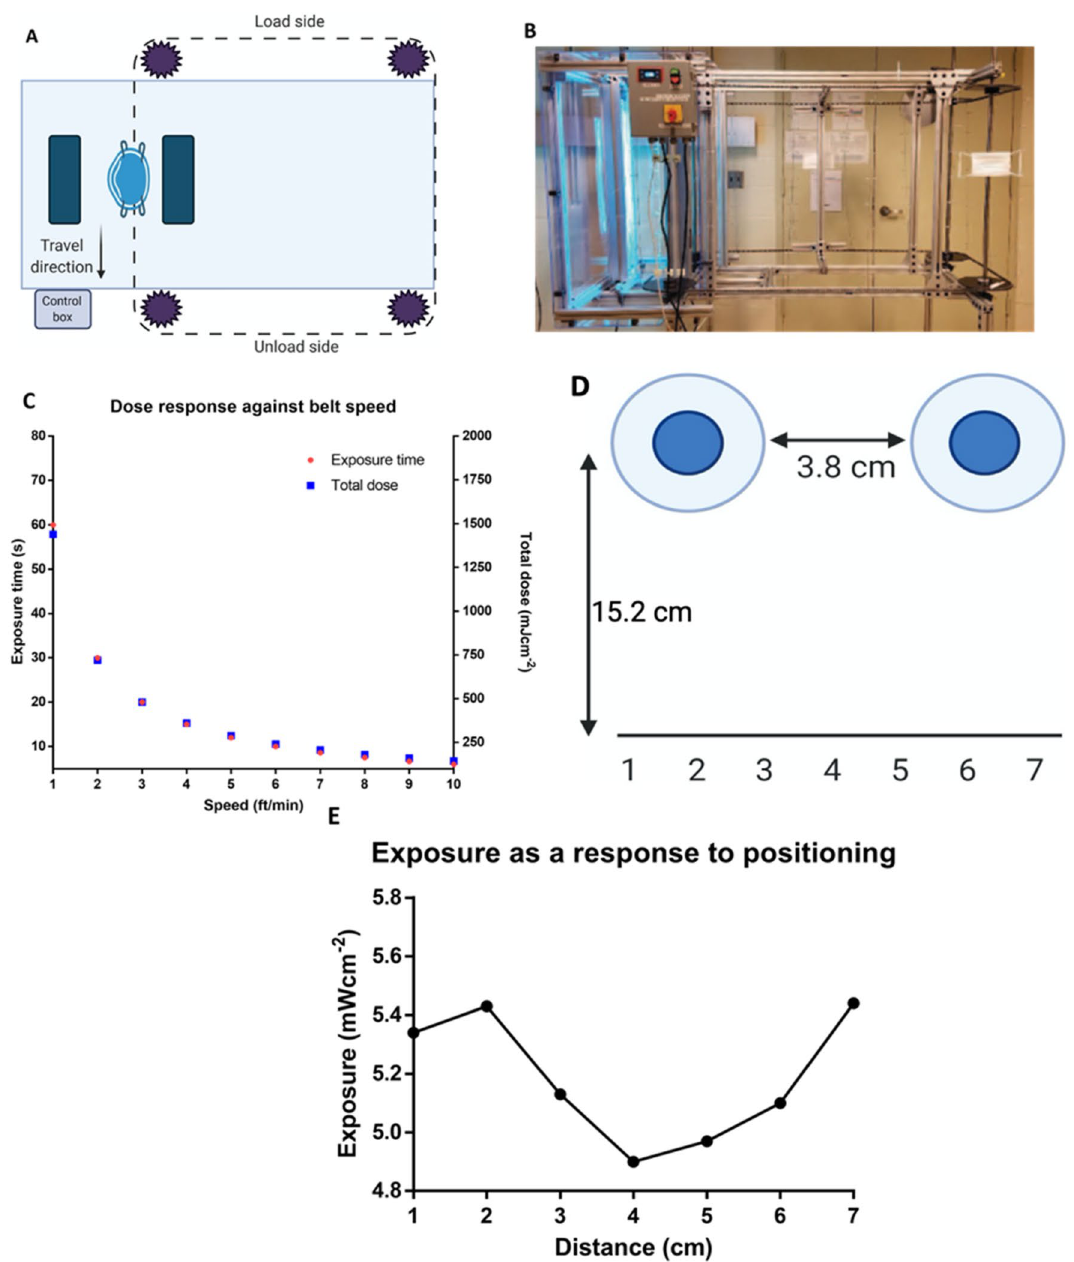
Figure 1. Schematic, dose response and exposure characterization of the proposed UVC decontamination device. ( A ) Schematic of the operational germicidal device. The UVC germicidal device comprises a conveyor belt which is scalable. ( B ) Real image of the prototype germicidal device. ( C ) Changes to the dose response curve as a response belt speed. Total dose changes in response to the conveyor belt speed and exposure time. ( D ) Schematic of the experimental setup lamp and surface positioning. The germicidal lamp bulbs contain 3.8 cm between them and the distance from the lamp to the surface is 15.2 cm. Exposure changes as a result of positioning was monitored. ( E ) Exposure profile of the lamp based on the surface placement as indicated in ( D ). The UVC 254 nm detector was placed in positions 1 cm apart, covering a total distance of 7 cm. Measurements were taken at 3 min at each time point after initial lamp warm